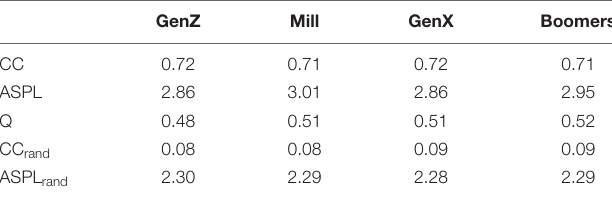
CC–clustering coefficient; ASPL–average shortest path length; Q–modularity measure; CCrand–Clustering coefficient of random graph; ASPLrand–average shortest path length of random